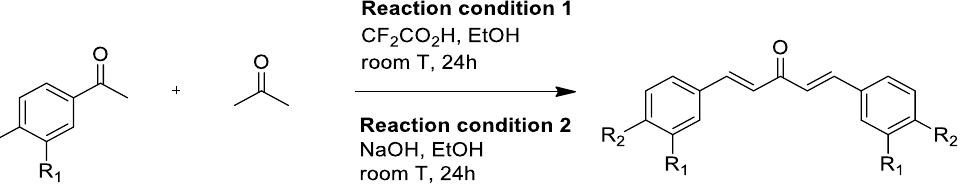
Figure 18. Reaction scheme showing the synthesis of monocarbonyl curcumin derivatives ( 43 – 47 ).